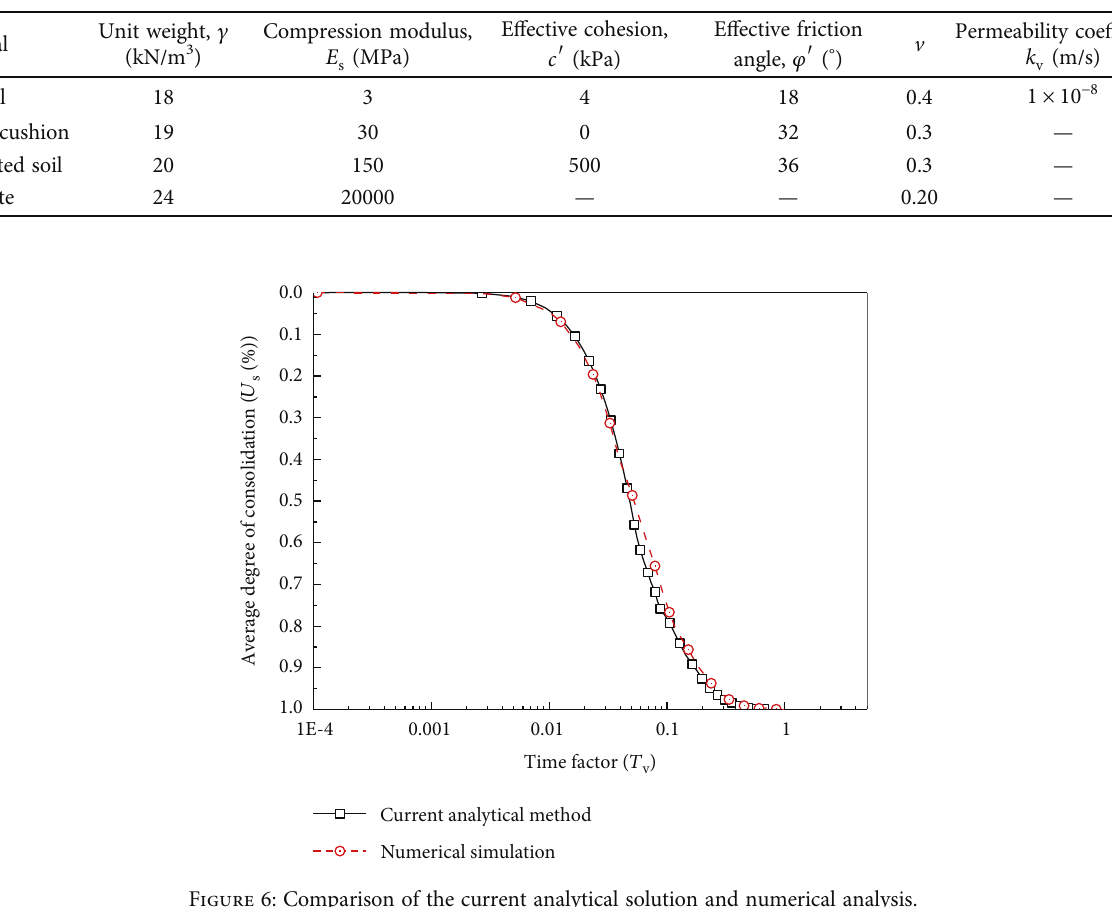
Table 1: Parameters in the numerical simulation.